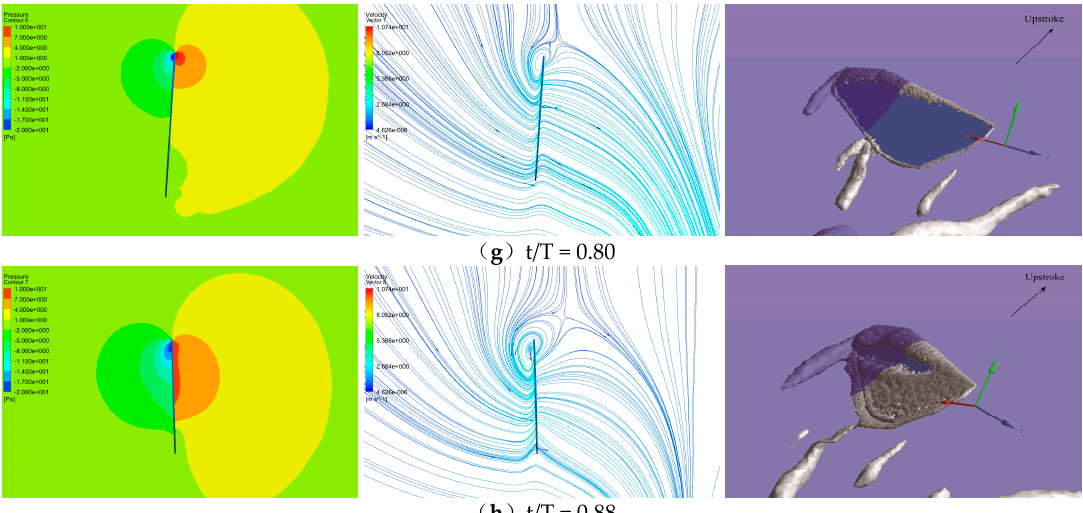
Figure 11. Pressure contours (left), streamlines (middle) and iso-vorticity surfaces (right). At different time instants with PAM 8%T in one cycle of hovering motion ( a – h corresponds to t / T = 0, 0.1, 0.22, 0.34, 0.5, 0.62, 0.80 and 0.88, respectively).